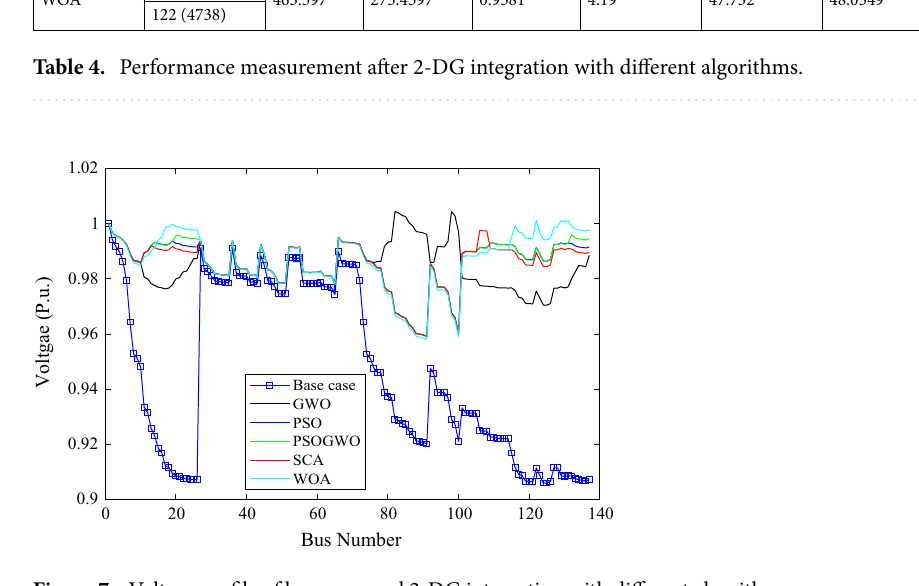
Figure 7. Voltage profile of base case and 2-DG integration with different algorithms.